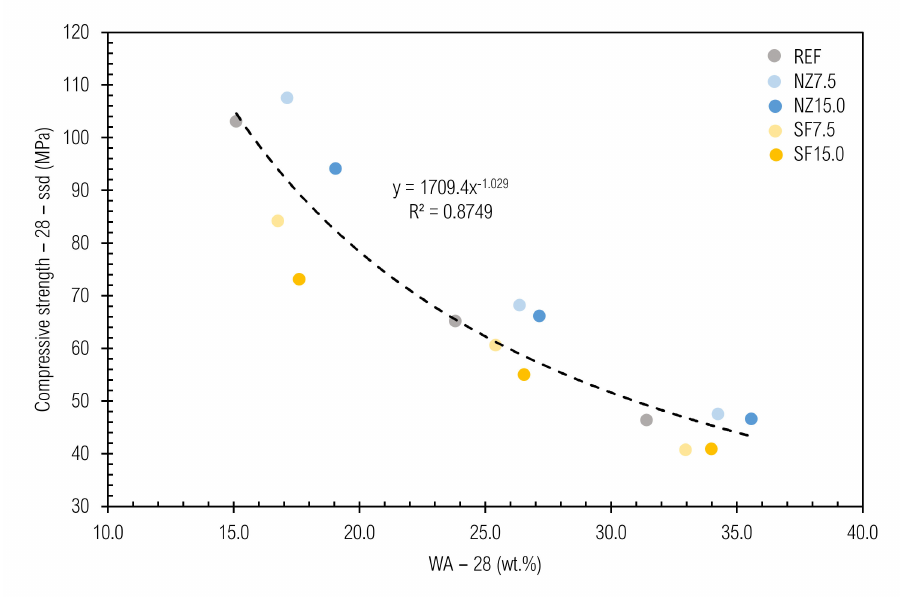
Figure 12. Relation between f c − 28 − ssd and real WA − 28.